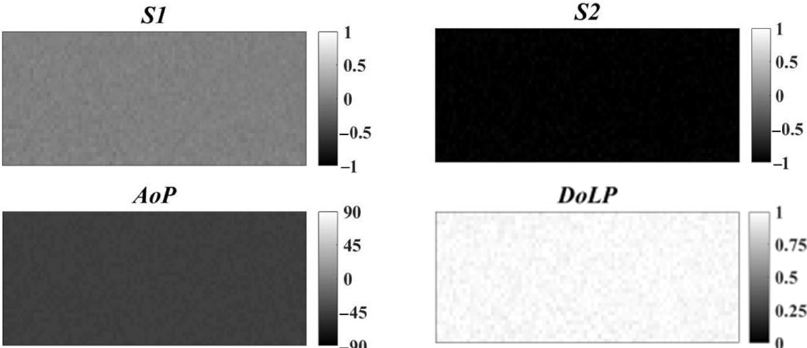
Figure 9. The polarization parameters calculated using the broadband object.